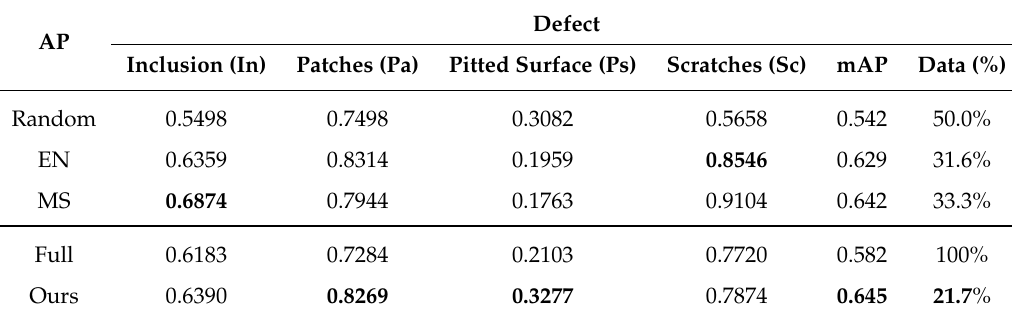
Table 3. Comparison of Average Precision (AP) on the NEU-DET dataset. The best results are shown in